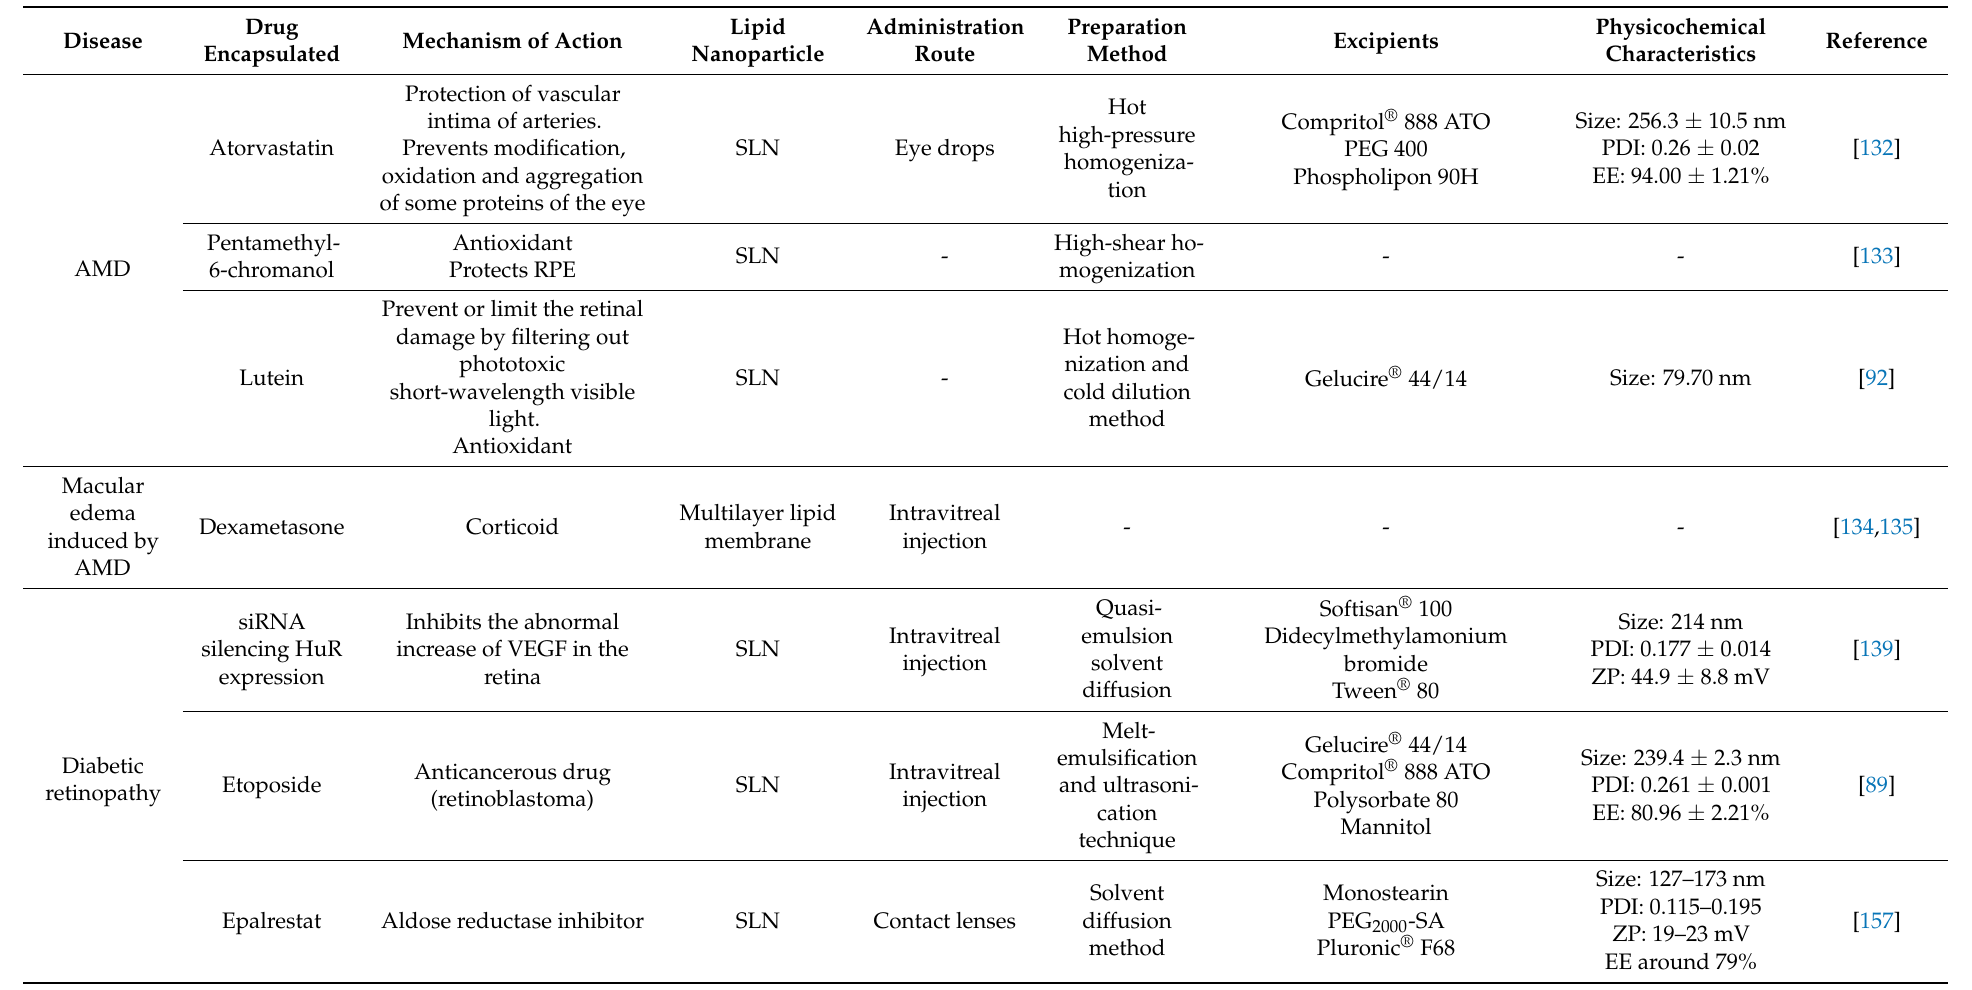
Table 1. New treatment approaches for AMD, macular edema induced by AMD, diabetic retinopathy, uveitis and glaucoma using lipid